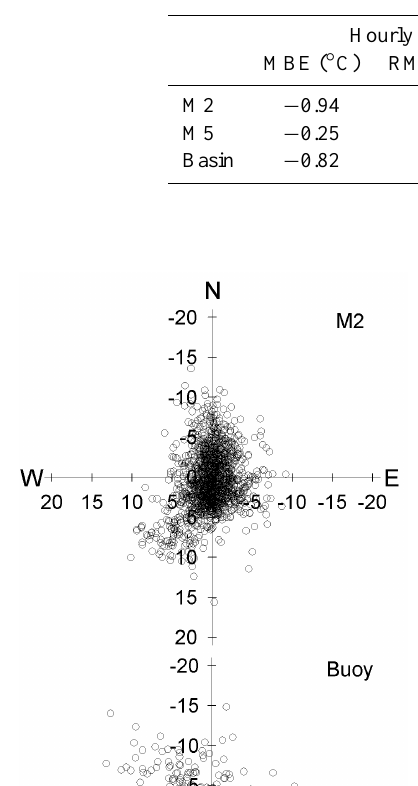
Table 5. Hourly and daily statistics for the dew point temperature in terms of mean bias error (MBE) and root mean square error (RMSE).